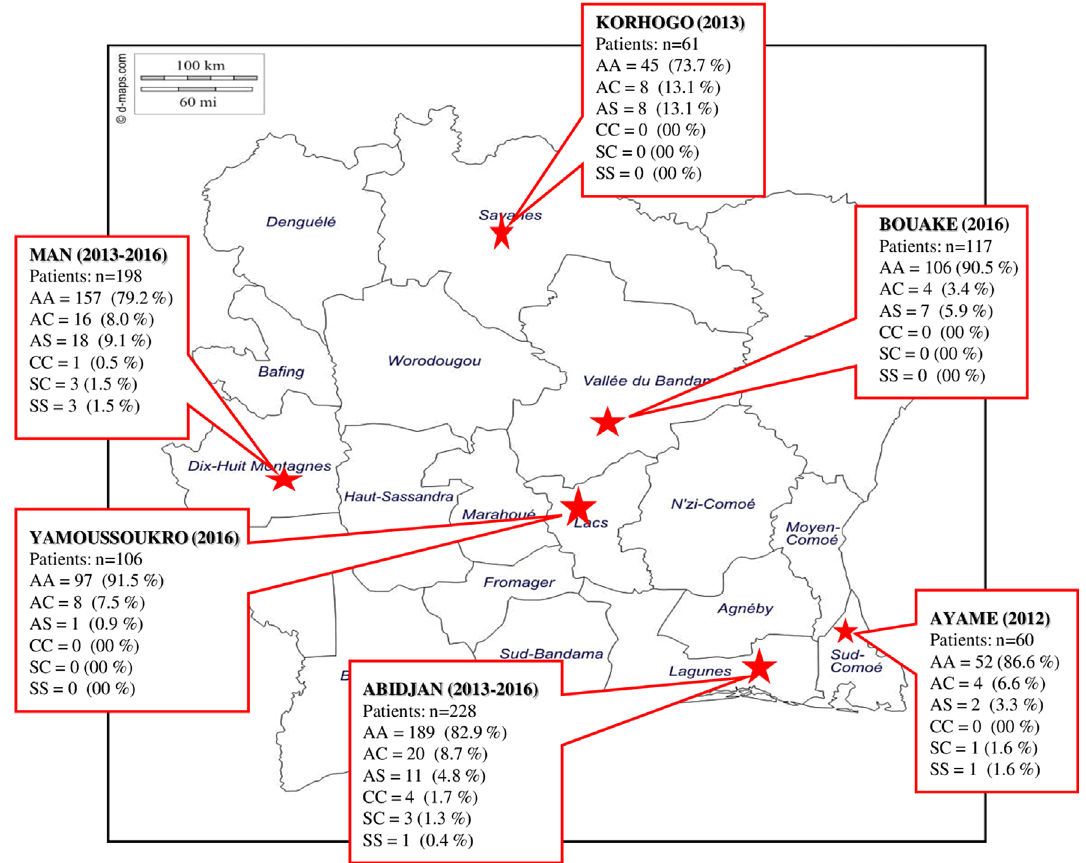
Figure 1. Map of Côte d ’ Ivoire with site locations and prevalence of hemoglobin